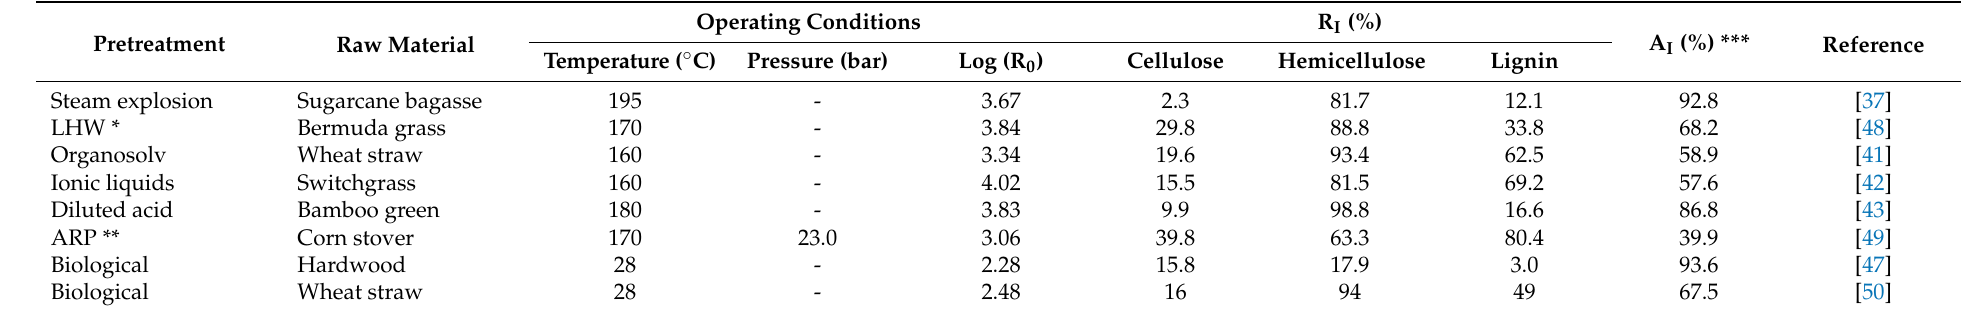
Table 2. Pretreatment screening for hemicellulose